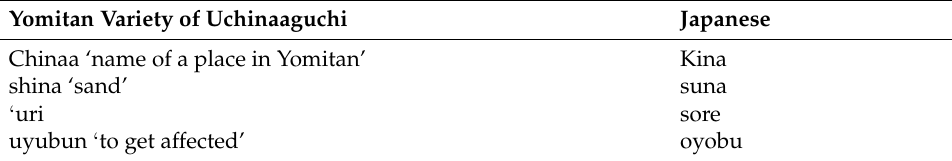
Table 2. Phonological correspondences between the Yomitan variety of Uchinaaguchi and Japanese from the story.